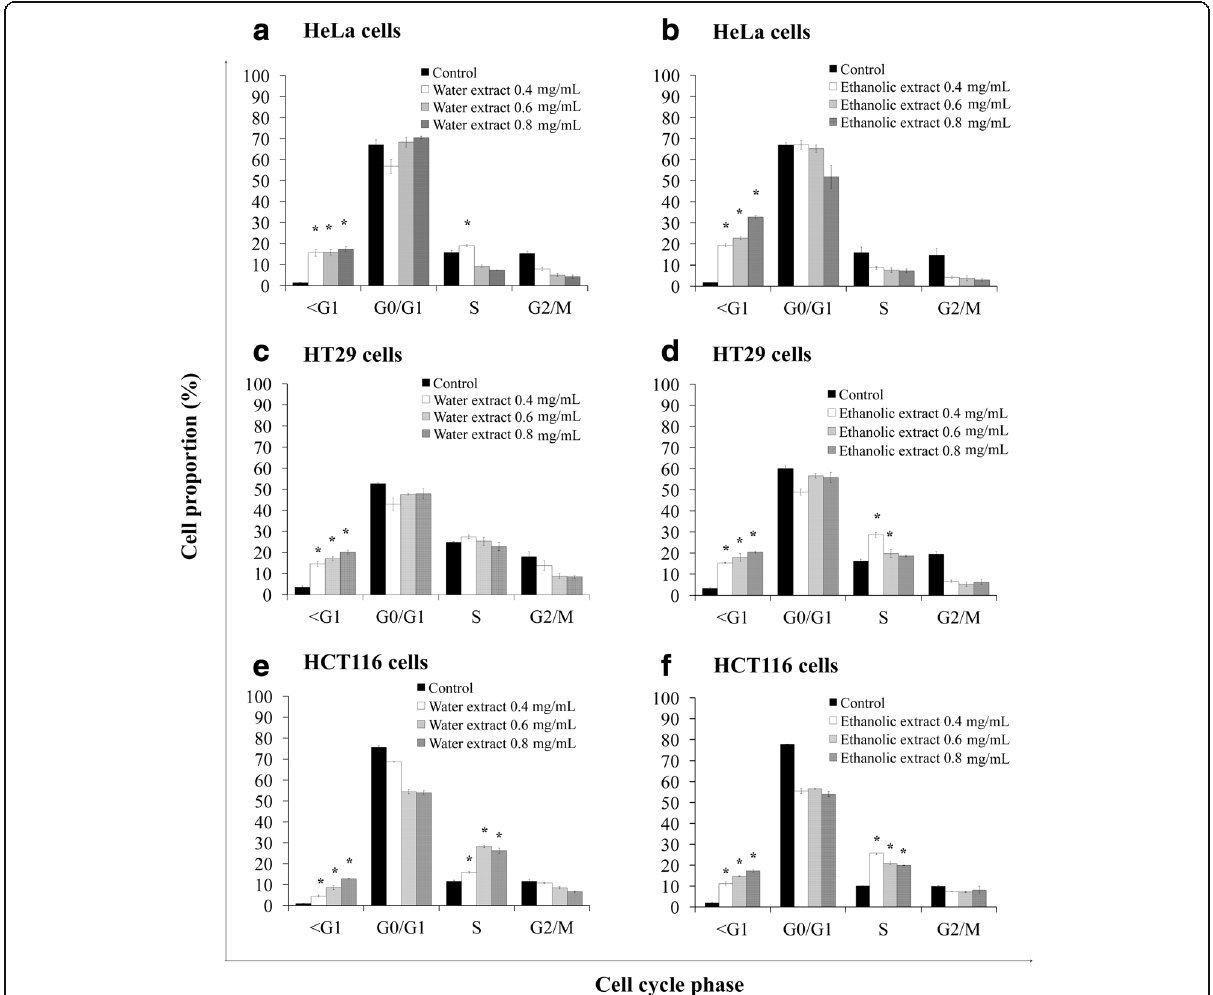
Fig. 5 Effects of water and ethanolic extracts prepared from the powdered formula of H. cordata fermented broth and P. emblica fruit on cell cycle progression were analyzed by flow cytometry after the cells were stained with propidium iodide. For cell cycle analysis, HeLa ( a , b ), HT29 ( c , d ) and HCT116 ( e , f ) cells were treated with or without (control) the extracts for 24 h. Cell numbers are presented as a percentage of the total analyzed cells. Each value is presented as mean ± SD from three independent